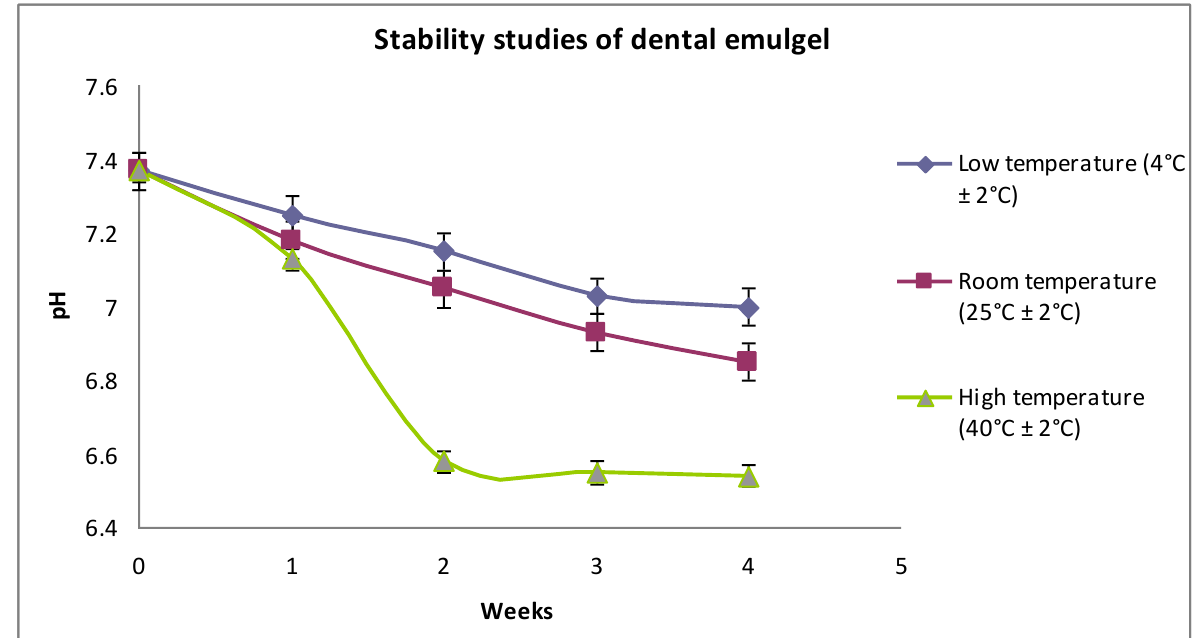
Figure 6. Effect of storage temperature on the short-term stability of NSO nanoemulgel (n = 3).